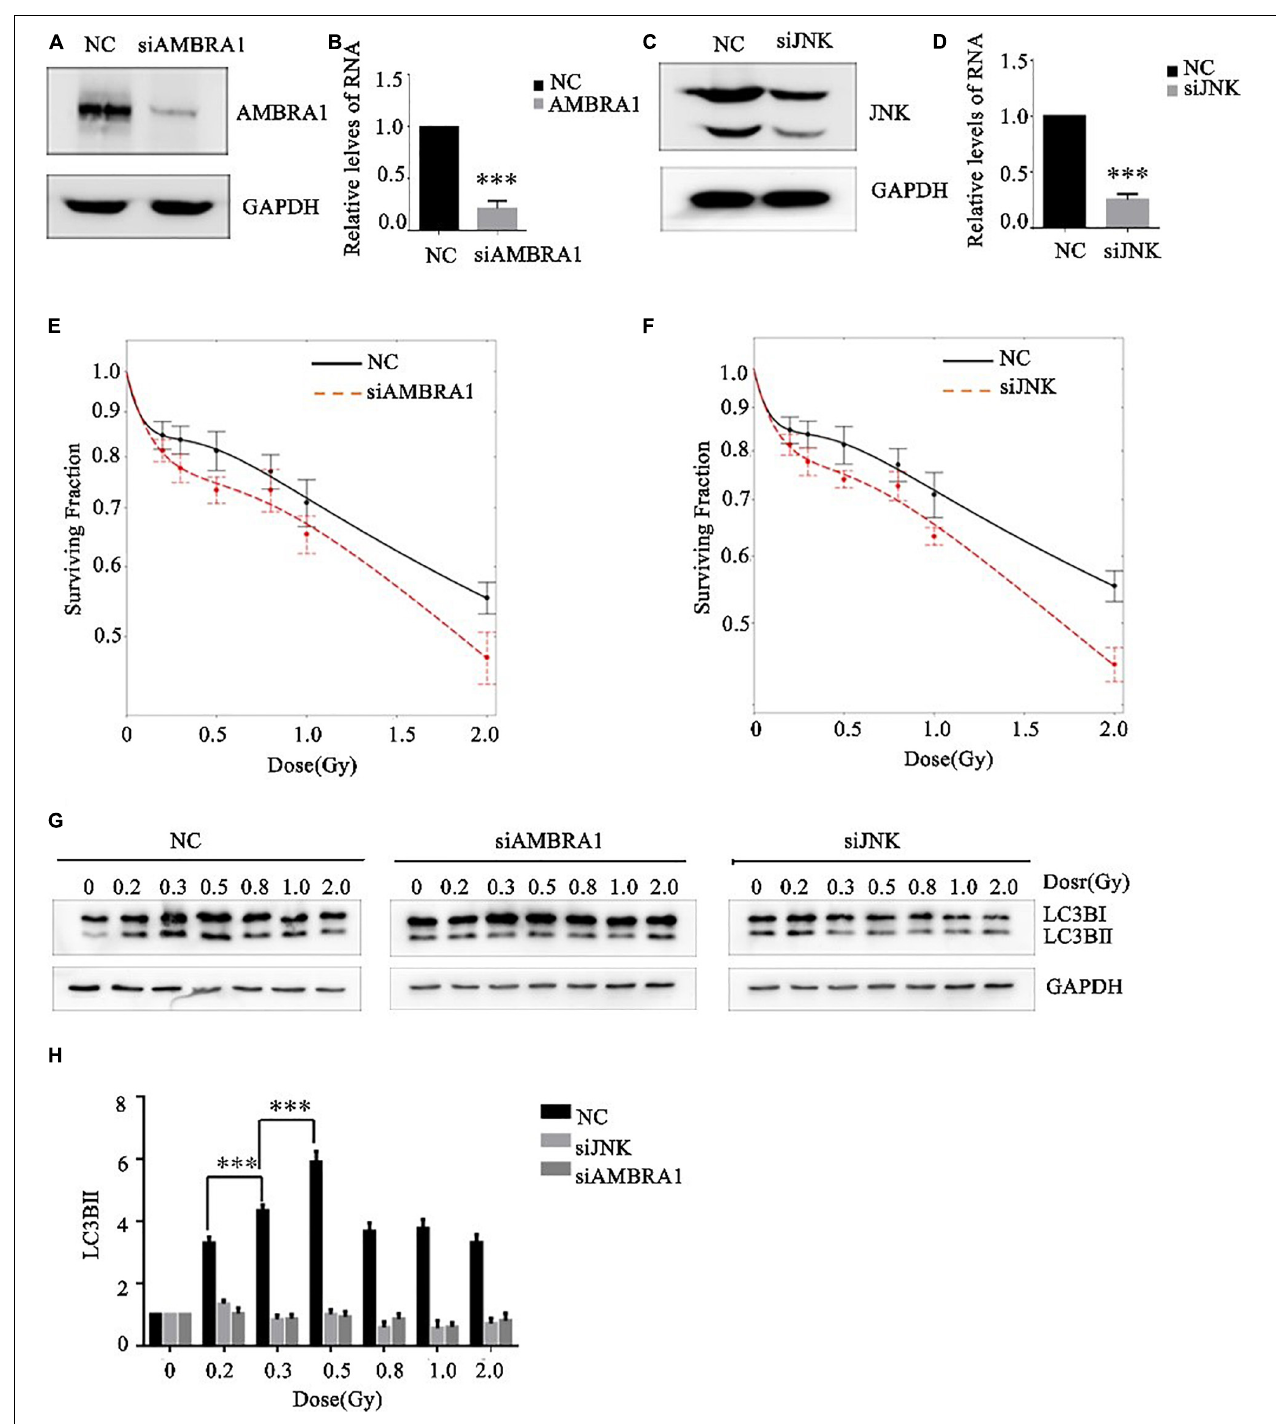
FIGURE 5 | Effects of AMBRA1 and JNK on the radiosensitivity and autophagy of A549 cells. (A,B) siRNA transfection inhibited AMBRA1 gene expression in A549 cells. (C,D) siRNA transfection inhibited JNK gene expression in A549 cells. (E,F) When AMBRA1 and JNK were knocked down in A549 cells, the sensitivity of cells to low-dose radiation increased, and the HRS phenomenon was enhanced. (G,H) When AMBRA1 and JNK were knocked down in A549 cells, cellular autophagy under low-dose radiation was inhibited. *** p < 0.001.